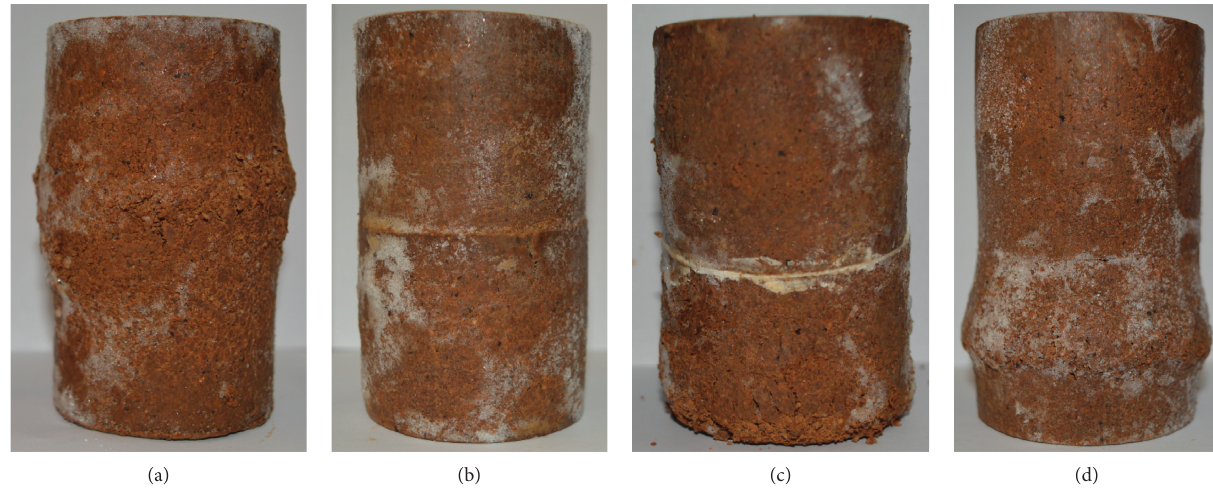
Figure 5: Static failure modes of frozen silty soil using three kinds of binder materials. (a) 0 cracks at 0.01s − 1 . (b) 1 crack with no binder at 0.01s − 1 . (c) 1 crack using plaster at 0.01 s − 1 . (d) 1 crack using Vaseline at 0.01s − 1